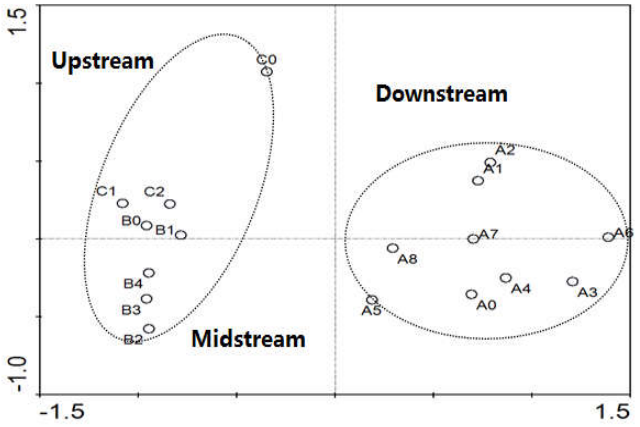
Figure 3. PCA analysis of the different samples from different depths in the sediment cores from the Xiangxi River. Samples A0~A8 were from the downstream, and samples B0~B4 and samples C0~C2 were from the midstream and upstream, respectively, which indicated a significant difference between the two groups at p < 0.05.